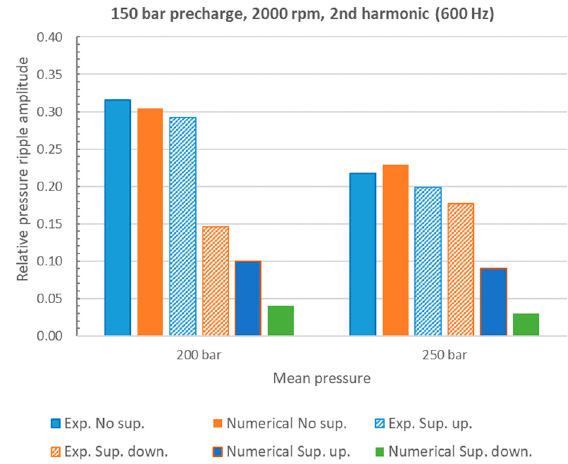
Figure 12. FFT of the pressure ripple, 2nd harmonic, pump speed = 2000 rpm.